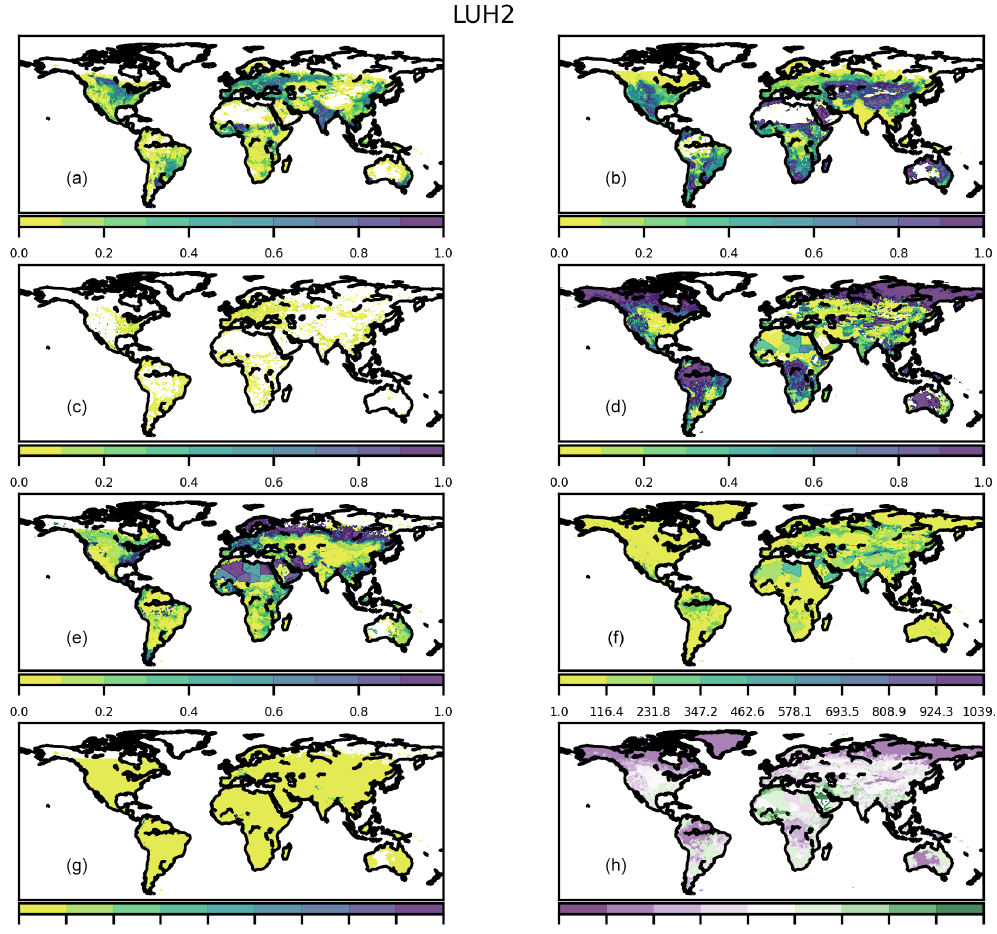
Figure 10. Maps for the year 2015 showing the following: (a) the fraction of each grid cell occupied by cropland; (b) the fraction of each grid cell occupied by pasture; (c) the fraction of each grid cell occupied by urban land; (d) the fraction of each grid cell occupied by primary vegetation; (e) the fraction of each grid cell occupied by secondary vegetation; (f) the mean age (in years) of secondary lands in each half-degree grid cell; (g) the mean gross transitions (km 2 yr − 1 ) over a 20-year interval for each grid cell; and (h) the mean net transitions (km 2 yr − 1 ) over a 20-year interval for each grid